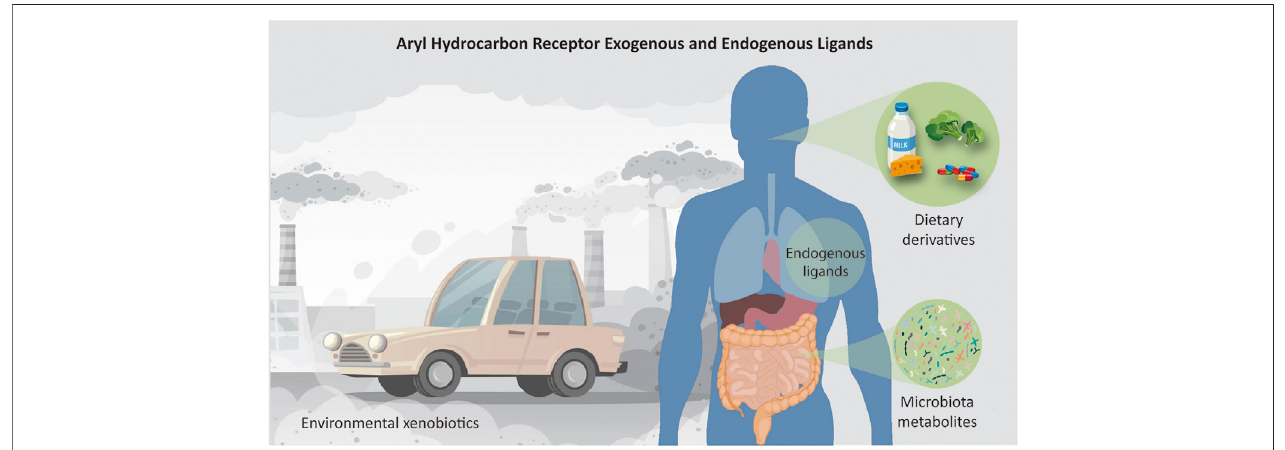
FIGURE 2 | Schematic representation of all sources of ligands that activate the AhR receptor. AhR is a cytoplasm-located transcription factor that shuttles to the nucleus upon binding of a range of molecules. The ligands can be, for example, environmental chemicals such as 2,3,7,8-Tetrachlorodibenzo-p-dioxin (TCDD) or polycyclicaromatichydrocarbonslikeBenzo(a)pyrene;plant-derivedmoleculessuchasindole-3-carbinol(I3C)anditsacidcatalyzeddimer,3,3 ′ -diindolylmethane(DIM), found in cruciferous vegetables; endogenous compounds, such as tryptophan-derived products like 6-formylindolo [3,2-b]carbazole (FICZ); products of commensal microbiota, e.g., indoles and naphthoquinone phthiocol; and medical drugs as omeprazole and tranilast. Conceived based on detailed lists of AhR ligands provided by